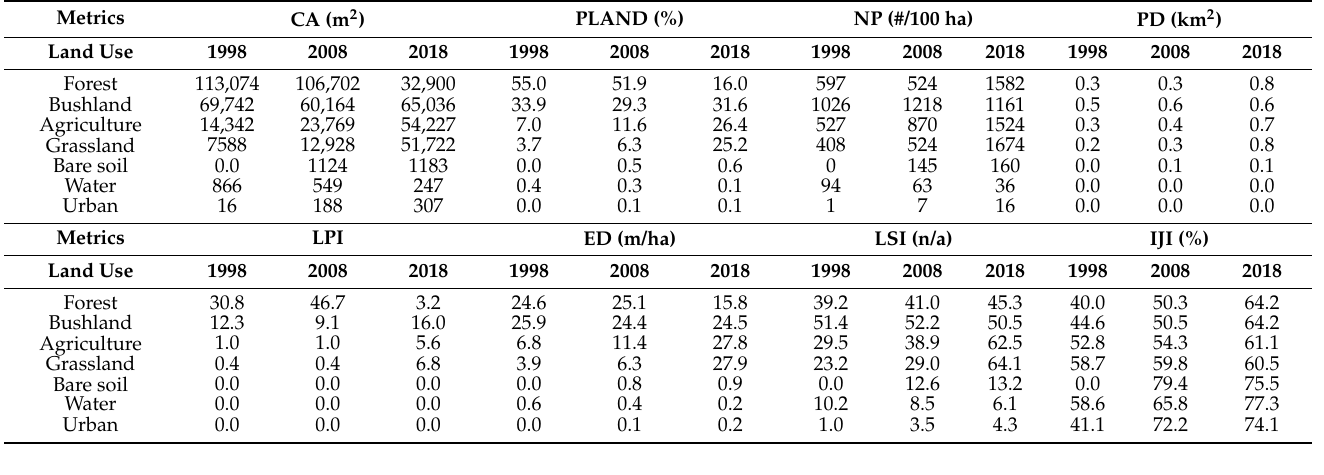
Table A2. Landscape fragmentation metrics used in this study (McGarigal, 2002) are compared over the years 1998, 2008, and 2018 for the study area in WMS wildlife corridor, Tanzania. Land-cover classes according to Table 3. CA = class area, PLAND = percentage of landscape, NP = number of patches, PD = patch density, LPI = largest patch index, ED = edge density, LSI = largest shape index, IJI = interspersion and juxtaposition index.